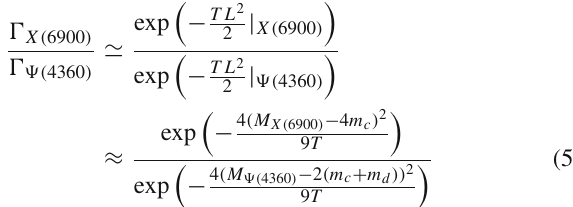
Table 3 Trajectories of the X ( 6900 ) , radial and orbital. We take values between 0.42 and 0.60 GeV − 2 for the radial trajectory slope α (cid:2) n , while α (cid:2) goes between 0.55 and 0.88 GeV − 2 . The X ( 6900 ) is assigned n = 0 J and J orb = 0,althoughweincludethepossibilitythatitisnottheground state by extrapolating backwards on the trajectory as well. The lower states are provisionally labeled by negative n or J orb , but in fact if they exist the lowest of them would be n = 0 and J orb = 0. For lower slopes the mass differences between successive states are higher and the intercept smaller (in absolute value). The intercept is obtained to be between − 2 . 3 and − 1 . 6 for the radial trajectory and between − 3 . 4 and − 2 . 1 for the orbital one, depending on the slope. We do not predict the quantum numbers of the states. States in the left table will all have the same J PC , while on the right J is increasing with alternating PC , as